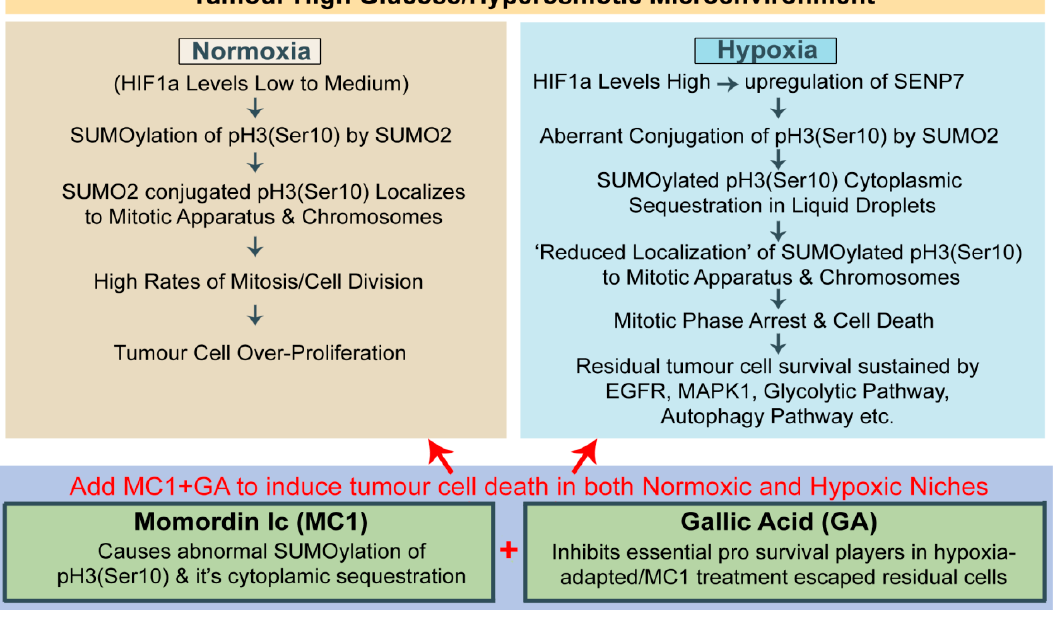
Figure 14. Momordin Ic (MC) and Gallic Acid phytochemical combination can hijack tumour cells’ pro-proliferative mechanoadaptation to high-glucose hyper-osmotic stress. In summary, it was found that in the normoxic HG microenvironment, tumour cells proliferate extensively as a biophysical adaptation to high-glucose hyper-osmotic stress (HG-HO), which predominantly involves an appropriate SUMOylation of pH3(Ser10). Acute hypoxia triggers the accumulation of abnormally SUMOylated pH3(Ser10) due to the upregulated activity of SENP7 that leads to mitotic arrest. Inhibition of SENP1 via Momordin Ic (MC) can cause similar M-phase arrest in proliferating normoxic cells, irrespective of HG and HG-HO pro-proliferative stress. The M-phase arrested population could be cleared by suppressing residual growth signalling via Gallic Acid (GA) treatment. Both MC and GA are enriched in Momordica charantia.